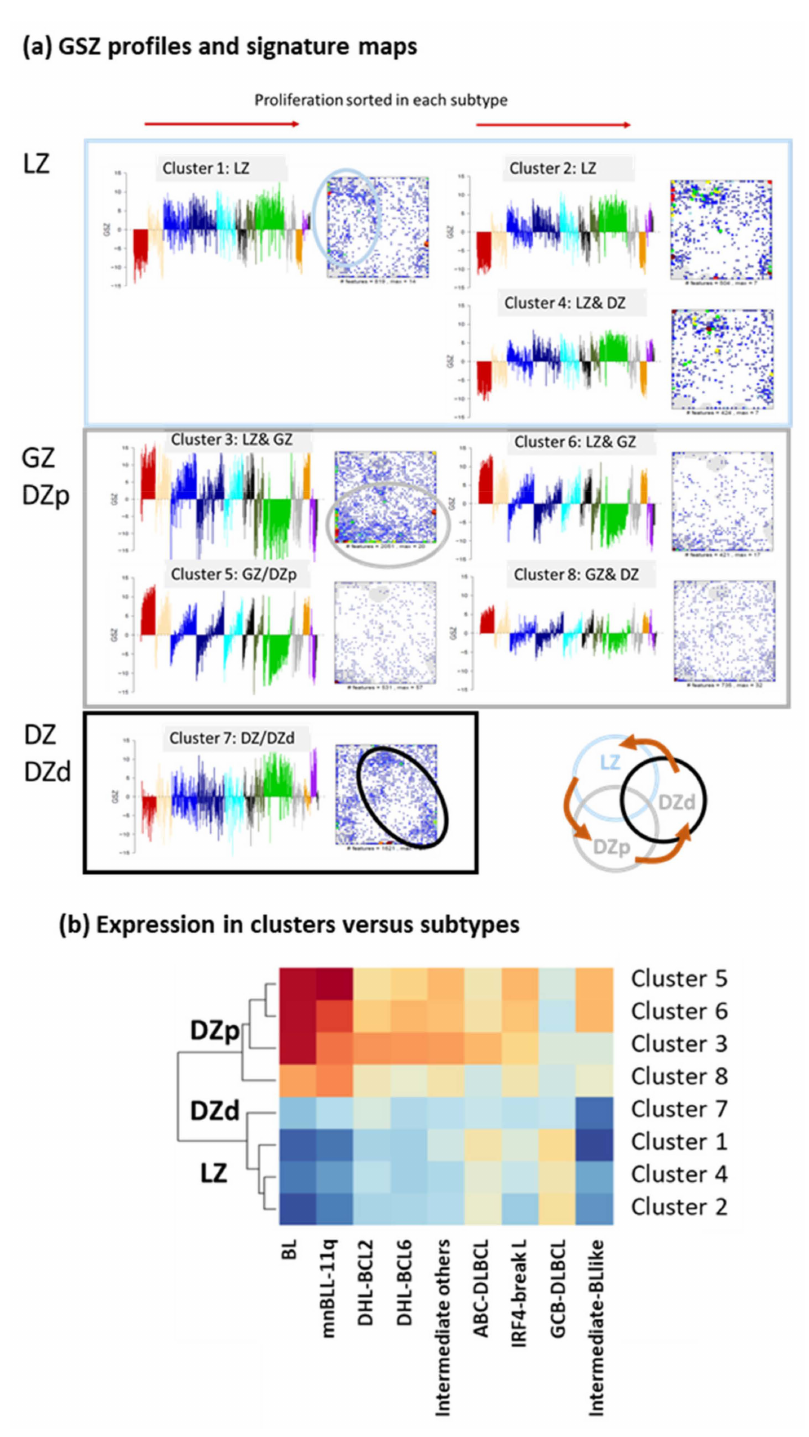
Figure A5. Mapping B-cell states in the GC as identified by Kennedy et al. [25] into the lymphoma transcriptome landscape: ( a ) Kennedy et al. identified 8 gene clusters which distribute over the GC states LZ, DZp (alias GZ, grey zone) and DZd as indicated in the figure. The clusters contain between 2887 (cluster 3) and 694 (cluster 4) genes (see [25]). The profiles reveal that DZp clusters are governed by cell cycle activity (tumors are ranked with increasing proliferation in each of the subtype), while LZ show higher activity in DLBC. The gene maps reveal accumulation of genes in different areas of the map as indicated by the circles which combine into the GC “circle” as visualized in Figure 2. ( b ) The heatmap shows the mean expression in the different subtypes and clusters. Hierarchical clustering splits DZp, DZd and LZ in a vertical direction, where DZp reflects BL-resemblance, LZ reflects DLBCL resemblance and DZd shows activation in BCL2